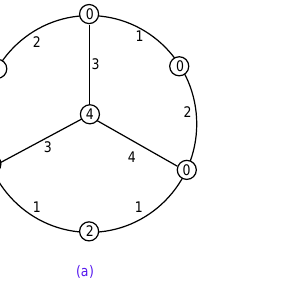
Figure 1. ( a ) A reflexive irregular 4-labeling of J 1